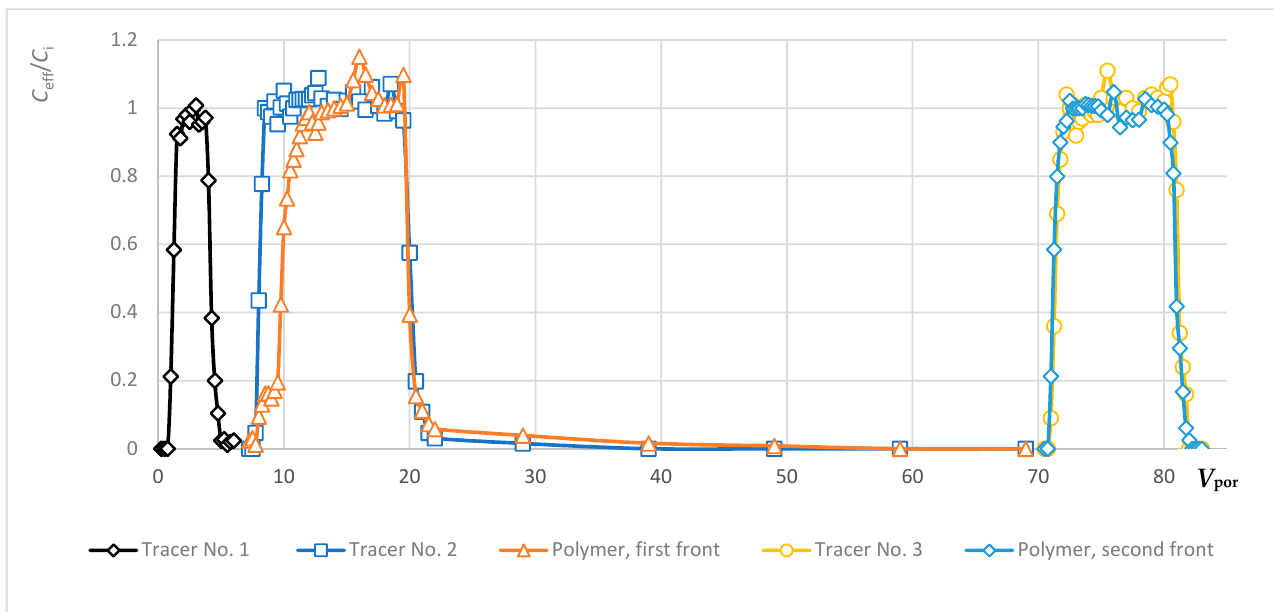
Figure 8. Normalized concentration ( C eff / C i ) of tracers and polymer in successive samples of the 6th filtration experiment. C eff represents the measured concentration in the effluents at each sampling interval (each dot on the curves) and C i represents the concentration of the fresh solution before injection.